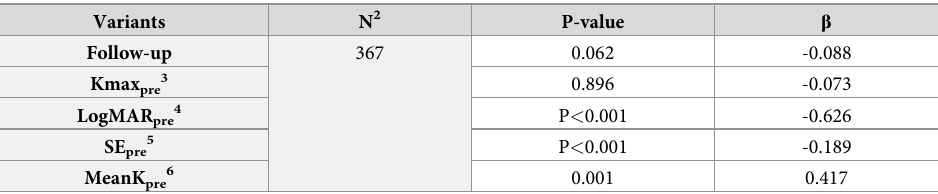
Table 6. Multivariate analysis of variables affecting Delta